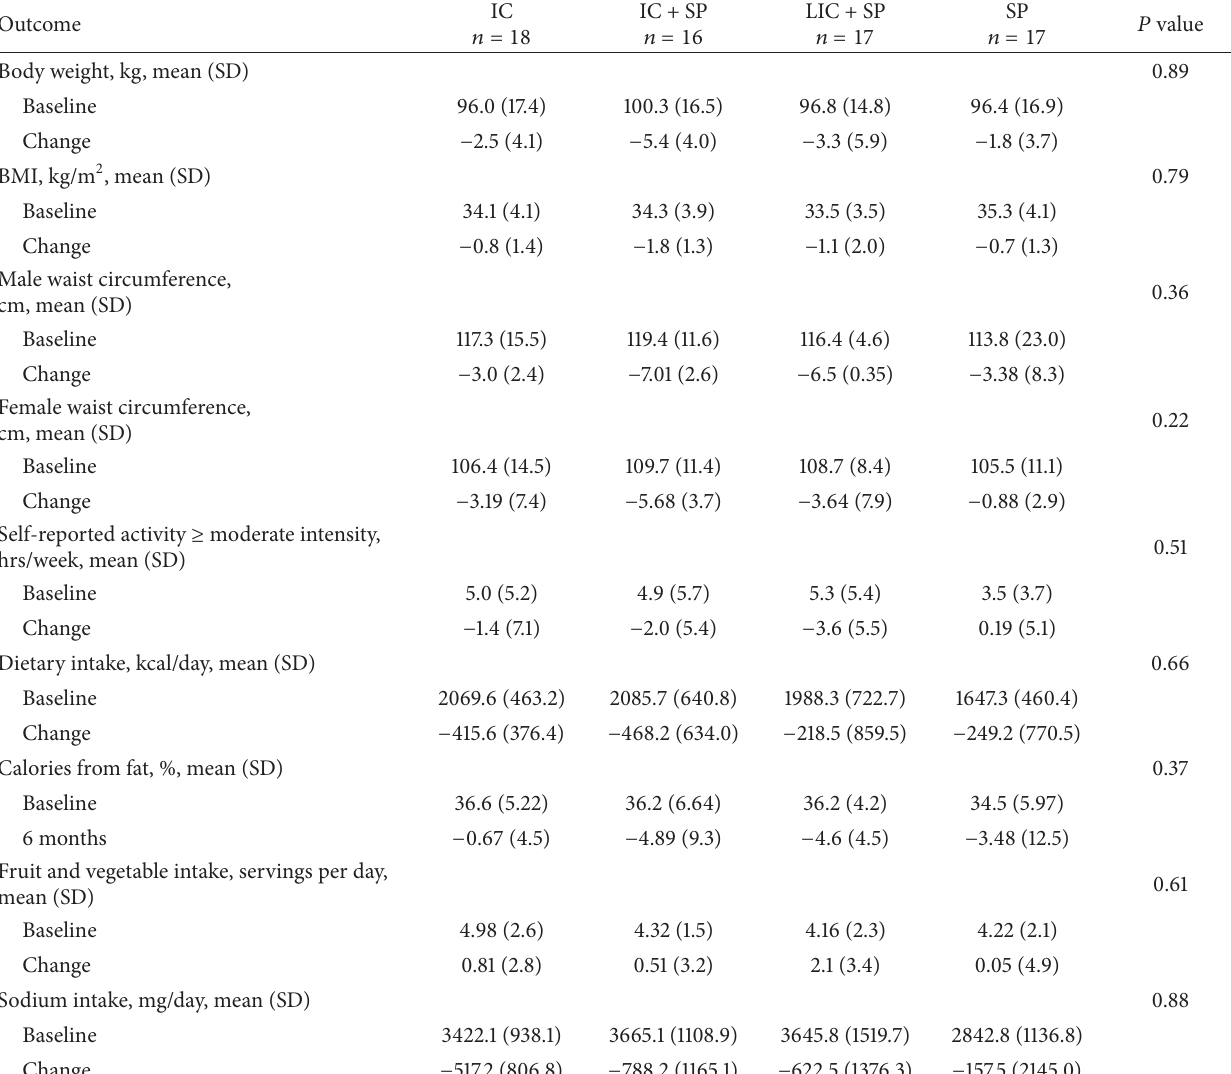
Table 3: Changes in outcomes by